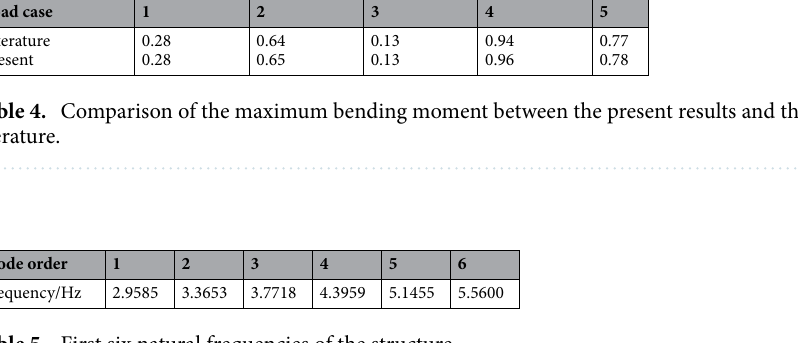
Table 5. First six natural frequencies of the